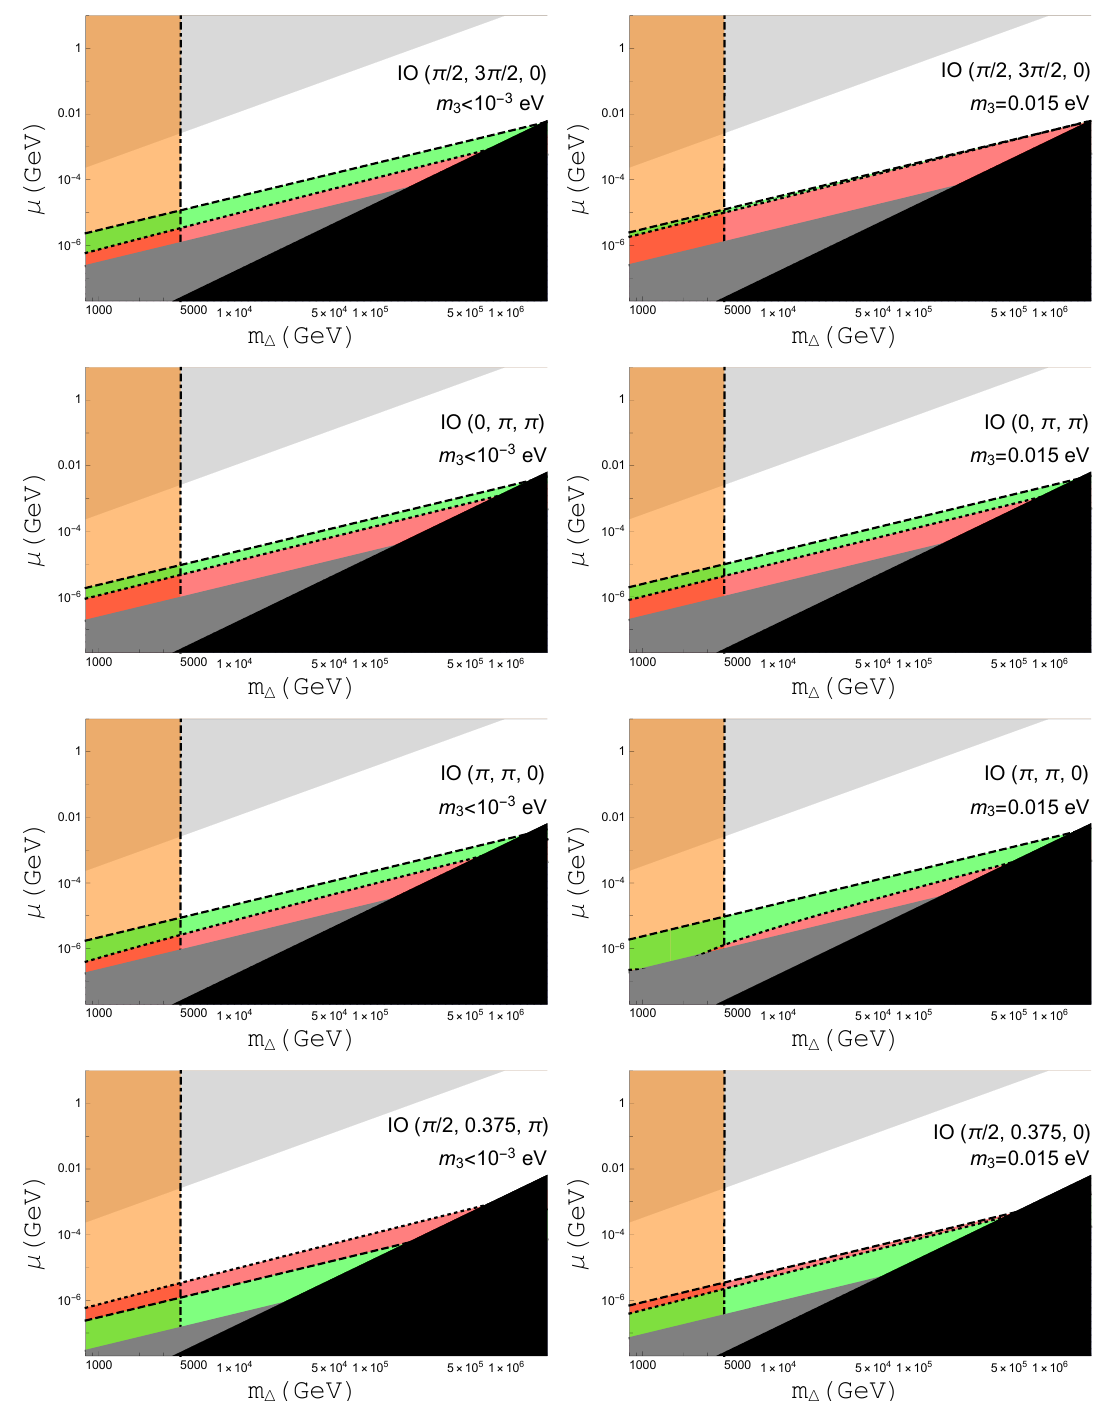
Figure 10 . The experimental sensitivities of LFV searches for the successful Type II Seesaw Leptogenesis parameter space is depicted for different CP phases parameter sets ( δ CP , α 21 , α 31 ) in the IO scenario with varying m 1 inputs and CP parameter